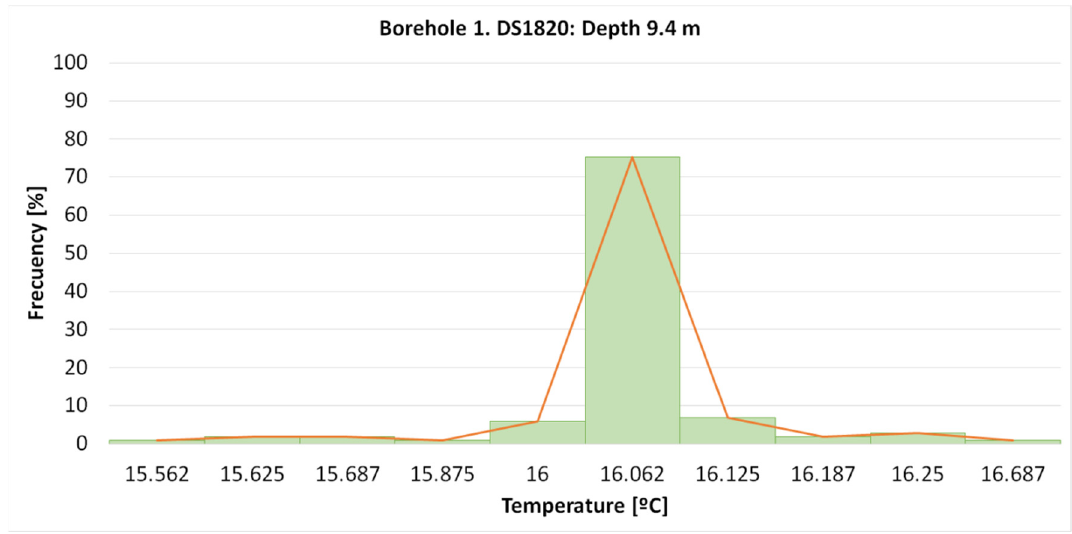
Figure 28. Histogram and frequency graph of DS18B20 sensor located at 9.4 m.